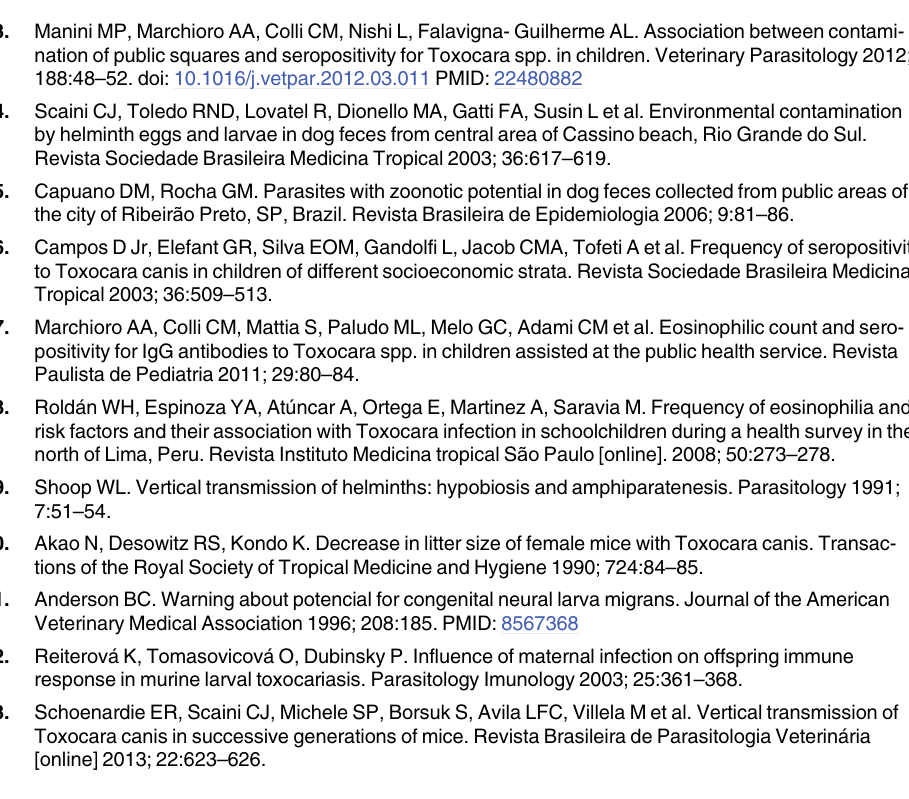
PLOS ONE | DOI:10.1371/journal.pone.0131058 July 6,